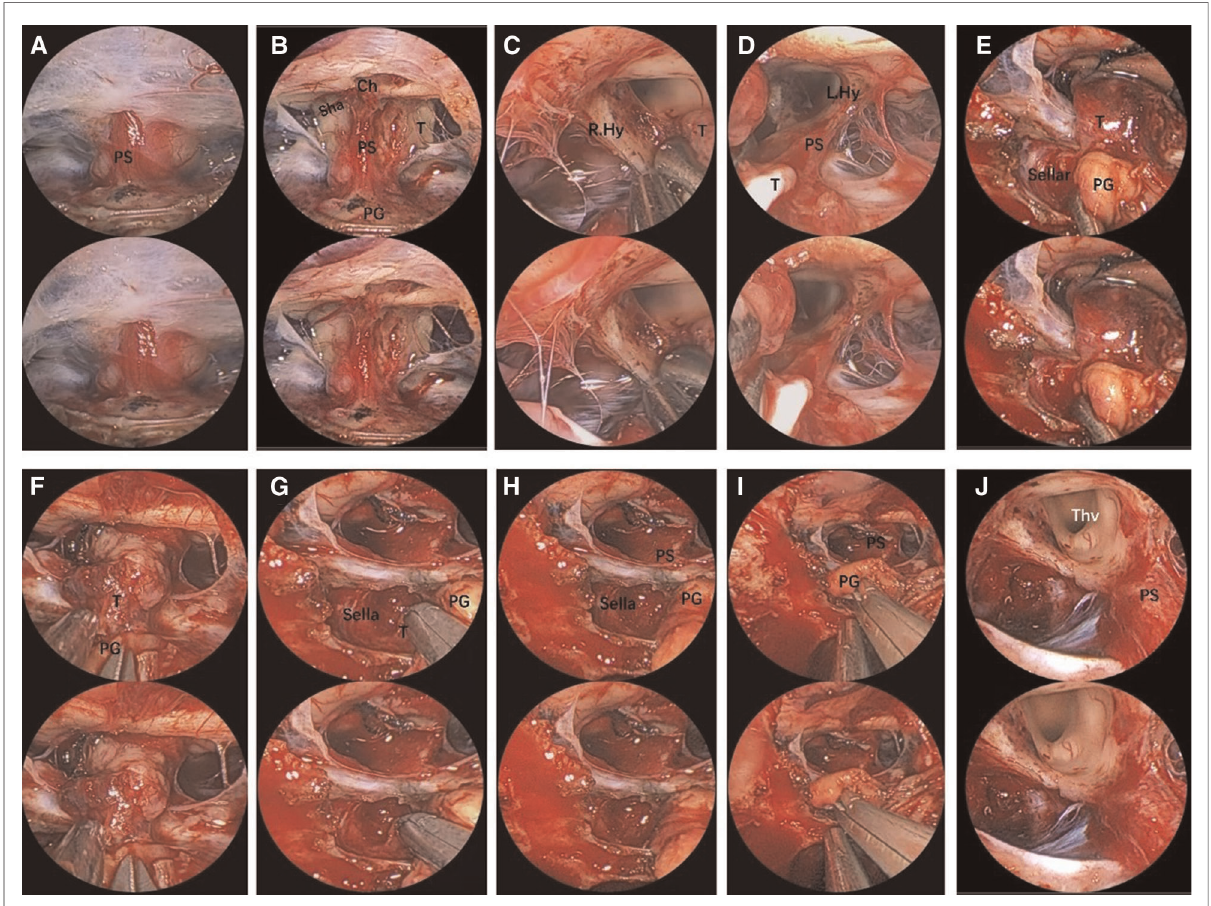
FIGURE 3 Endoscopic visualization of a suprasellar craniopharyngioma. ( A ) View of the pituitary stalk. ( B ) View of optic nerves, the chiasm, and the anterior complex during extracapsular dissection of tumor. ( C,D ) Close-up view of the pituitary stalk and optic nerves, crucial for tumor dissection. ( E,F ) Anatomical view of the main body of the suprasellar craniopharyngioma. ( G ) A view showing a small part of tumor in the sellar. ( H,I ) View of the PG was pulled and not in placed after surgery. ( J ) Final view of the third ventricle and pituitary stalk after craniopharyngioma removal. The 3D image can be obtained with cross-viewing method. PS, pituitary stalk; PG, pituitary gland; OC, optic chiasm; ON, optic nerve; sha, superior hypophyseal artery; T, tumor; ThV, third